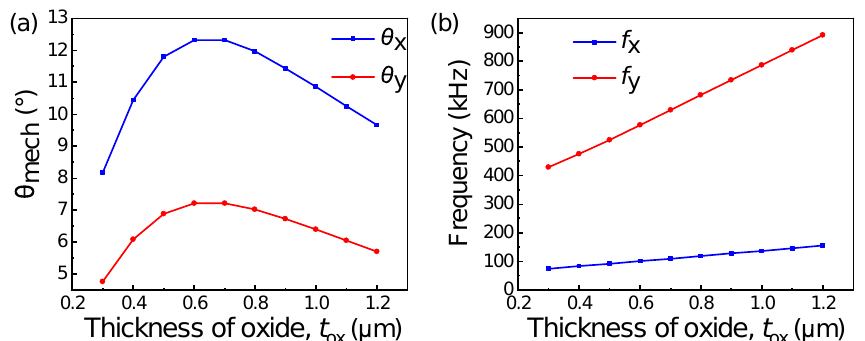
Figure 6. ( a ) Mechanical deflection angle of fast and slow scanning modes under different thickness of SiO 2 ( t Ox ); ( b ) resonant frequency of fast and slow sacnning modes under different thickness of SiO 2 ( t Ox